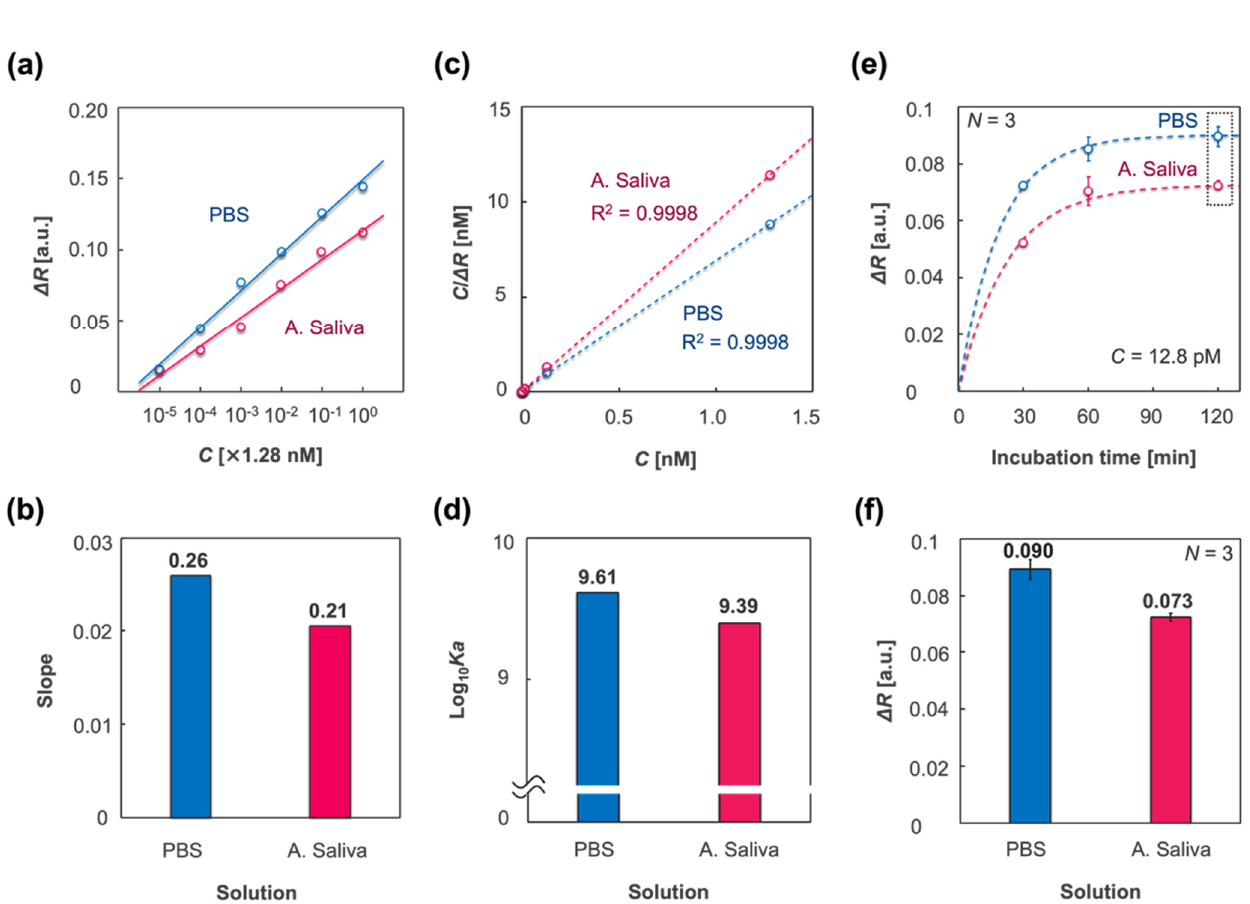
Figure 6. Characterization of the IPCF surface adsorption using different sample solutions: PBS (blue) and A. saliva (magenta). ( a ) Plots of responses to spike protein concentration C (M), which was derived from the plots in Figure 5e,f. ( b ) Slopes of the calibration curves in ( a ). ( c ) Langmuir adsorption isotherm applied to the IPCF surface, which was described as C / ∆ R = C / ∆ R max + 1/ ( ∆ R max Ka ) , where ∆ R max is the response when C was 1.28 nM and Ka is the binding constant. ( d ) Logarithmic binding constants estimated by applied adsorption isotherm. ( e ) Plots of responses to incubation time, t = 30, 60, 120 (min)., where the fitting curves are described by a first-order equation: ∆ R = ∆ R t = 120 { 1 − exp ( − ka ∗ t ) } , where ka is the binding rate constant. ( f ) Saturated ( t = 120 min) derived from the plots in the dashed square in ( e ). The values are described above the bars. Triplicate measurements were conducted with independent chips ( N = 3). Table 1. Comparison of nanomaterial-based immunosensors for Coronavirus detection.